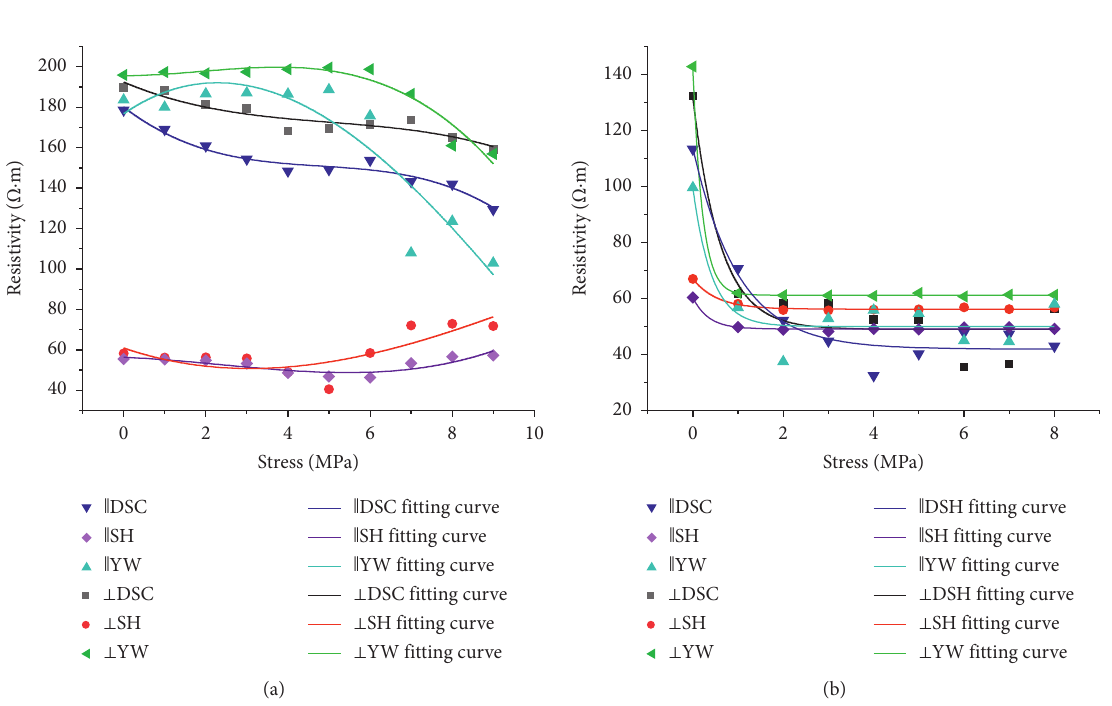
Figure 9: Resistivity fitting curve under stress. (a) Axial pressure. (b) Confining